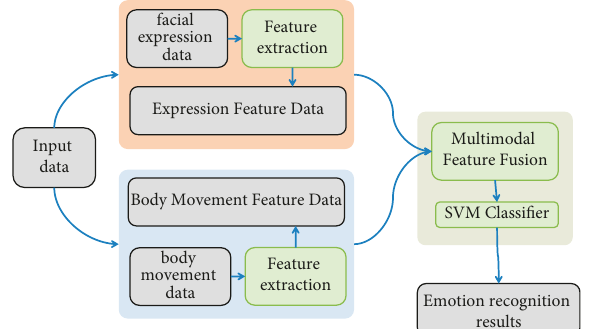
Figure 1: The principle diagram of mental state